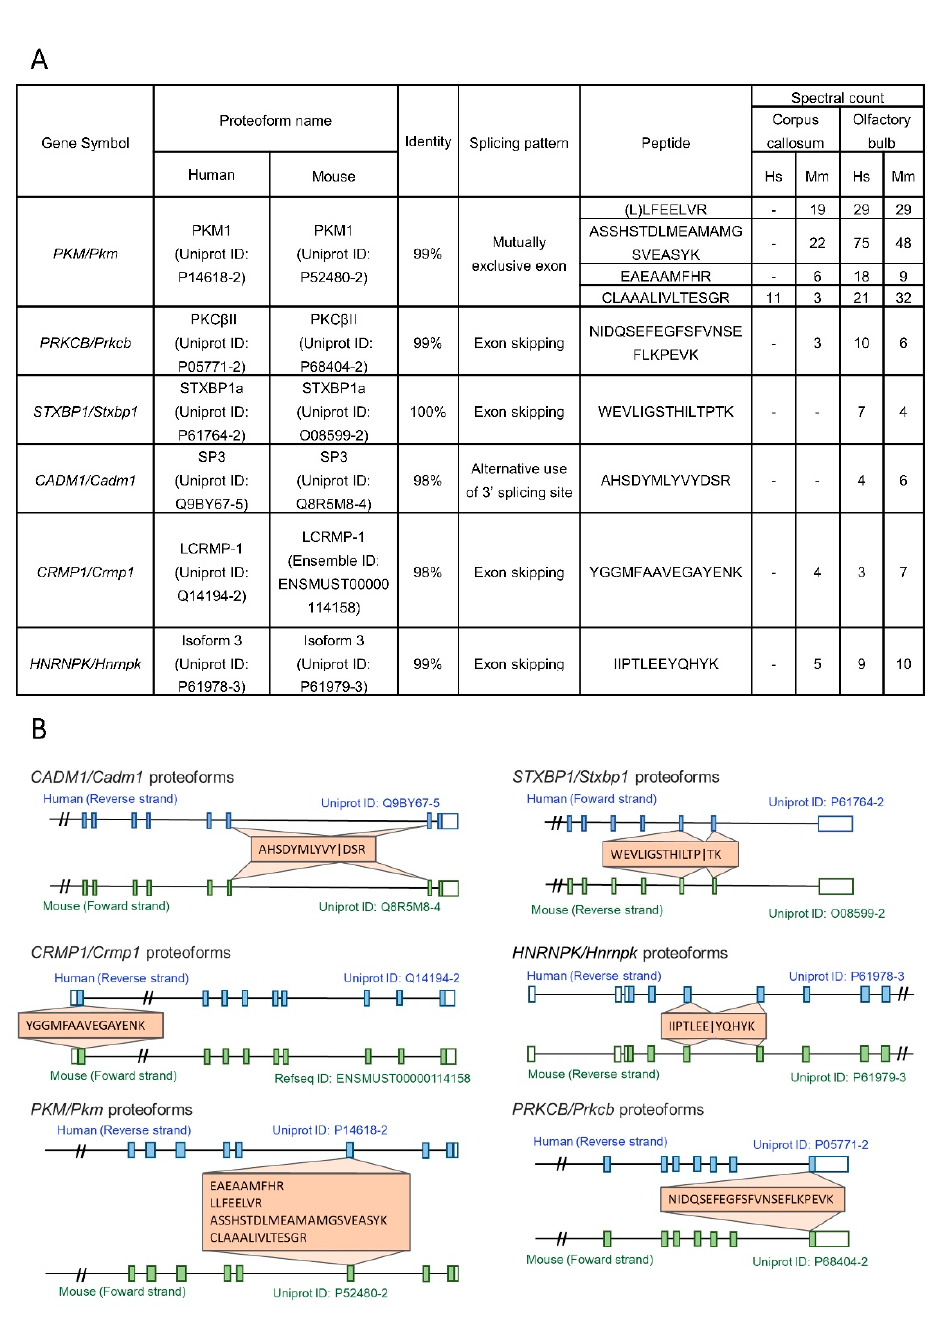
Figure 3. Exons and shared peptides of the orthologous alternatively spliced proteoforms. ( A ) Table with general information about the human (Hs) and mouse (Mm) proteoforms: gene symbol, proteoform name, identity, splicing pattern, identified peptides, and their spectral count in each brain region. ( B ) Schematic representation of the spliced transcripts of the genes CADM1/Cadm1; STXBP1/Stxbp1; CRMP1/Crmp1; HNRNPK/Hnrnpk; PKM/Pkm; PRKCB/Prkcb and the exon location of their identified peptides. Human proteoforms are represented in blue and mouse proteoforms are represented in green. Exons are represented by full (coding sequences) and empty (UTRs) boxes, while introns are represented by lines. Each peptide is represented with orange boxes. The two slashes in the intronic region indicate a fragment of mRNA structure not represented in the schematic.